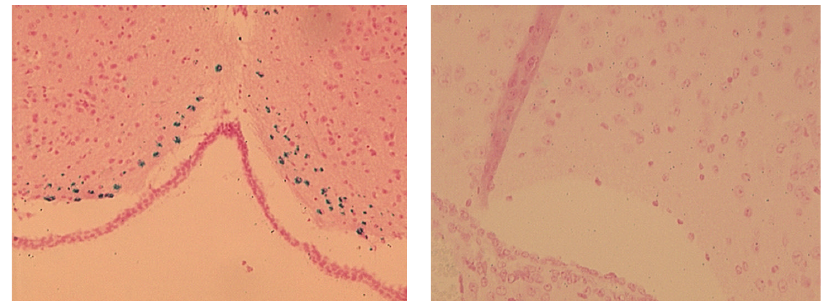
Figure 11: Fe 2+ staining in 3 × Tg